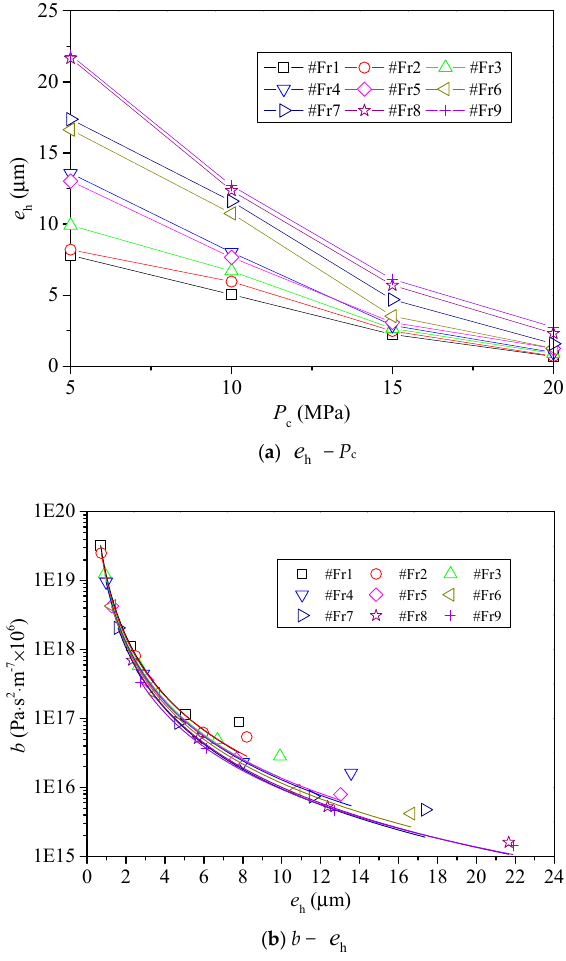
Figure 7. ( a ) variations in hydraulic aperture e h with confining pressure, and ( b ) regression analysis of nonlinear coefficient b against e h .